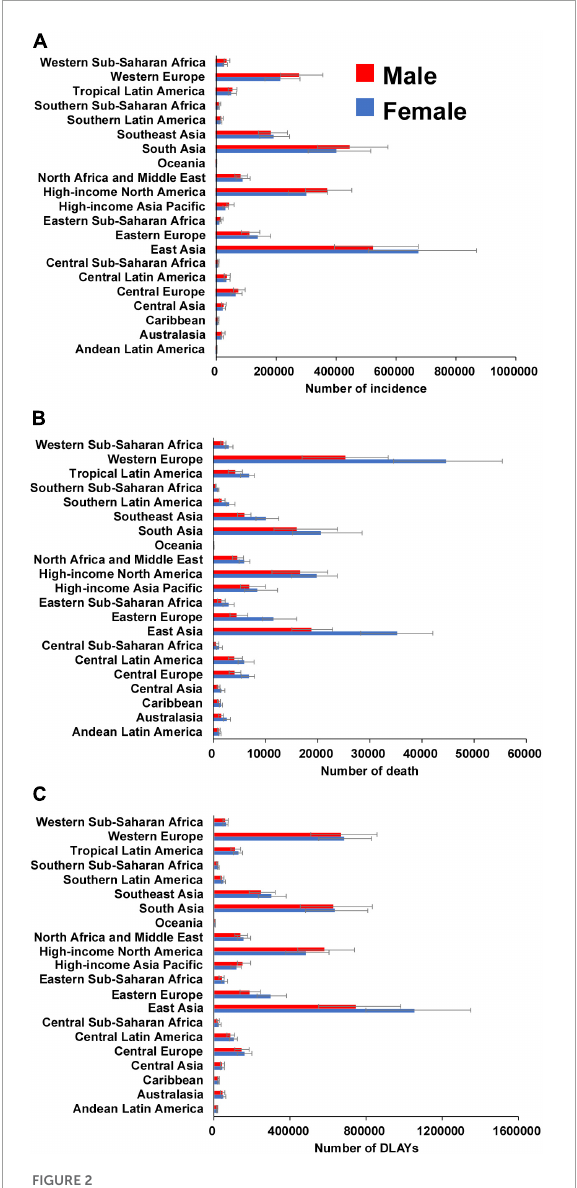
FIGURE2 The number of incidence (A) , death (B) , and DLAYs (C) of atrial fibrillation for 21 GBD regions by sex in 2019. Error bars indicate 95% uncertainty intervals. GBD, Global Burden of Diseases; DLAYs, disability-adjusted